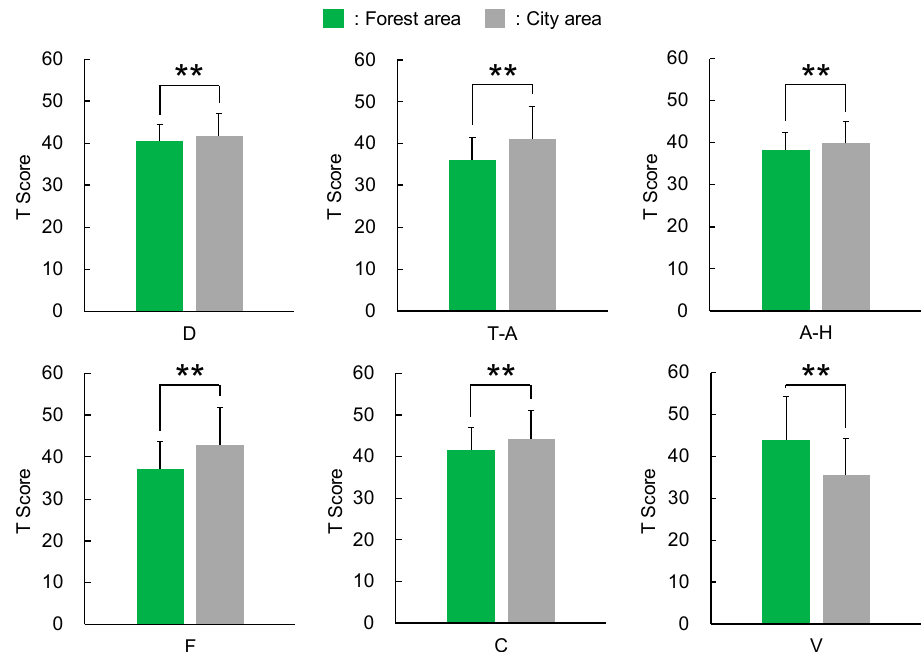
Figure 3. Scores of the Profile of Mood States after walking through forest and city areas. (D), depression– dejection; (T-A), tension–anxiety; (A-H), anger–hostility; (F), fatigue; (C), confusion; and (V), vigor. N = 585; mean ± standard deviation; **, p < 0.01 by Wilcoxon signed-rank test. Lines 5–14 on page 5 should be replaced with the following text: